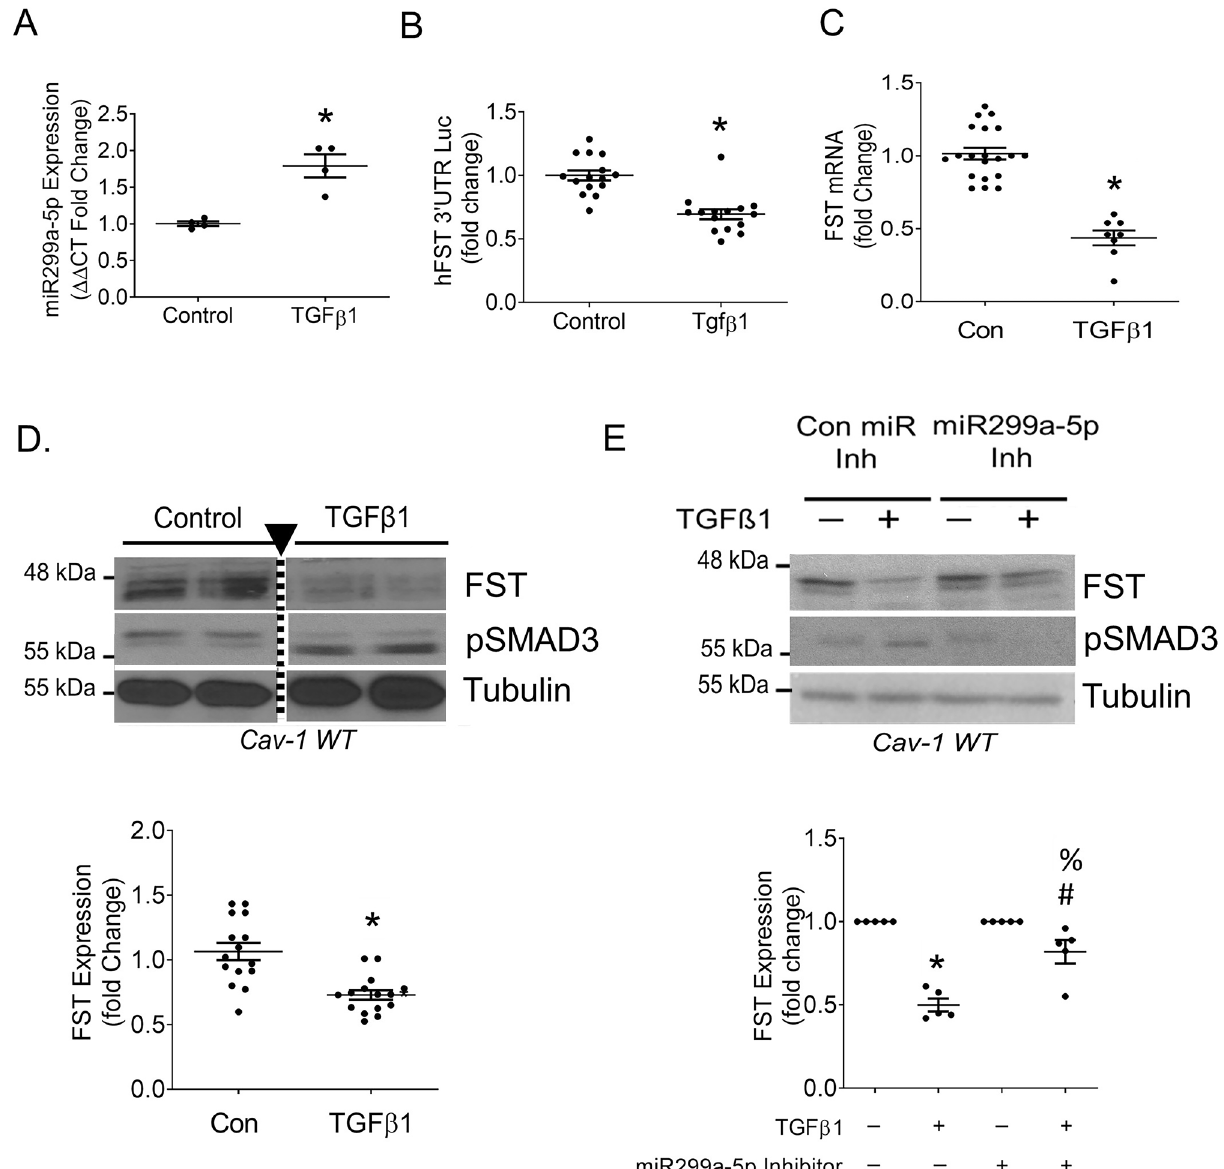
Figure 3. TFGβ1 represses FST through miR299a-5p upregulation in cav-1 WT MC. ( A ) TGFβ1 (5 ng, 24 h) increased the expression of miR299a-5p (n = 4, *p < 0.05) and ( B ) decreased stability of the FST 3 ′ UTR (n = 15, *p < 0.05). ( C ) TGFβ1 (5 ng, 24 h) reduced FST mRNA transcript (n = 8, *p < 0.05) ( D ) TGFβ1 (5 ng, 24 h) reduced FST protein expression (n = 4, *p < 0.05), while inducing phosphorylation of Smad3, triangle pointing to the dotted line indicates an edit made on the immunoblot image, where additional lanes not relevant to the experiment were cropped out, full gel provided in Sup Fig. S8). ( E ) Inhibition of miR299a-5p blunted the ability of TGFβ1 (5 ng, 24 h) to reduce FST protein expression, while reducing the phosphorylation of Smad3 (n = 5, *vs con inh-con, #vs miR inh-con, %vs con inh-TGFβ1, p < sion in cav-1 WT MC, and observed that this significantly blunted the ability of TGFβ1 to induce extracellular matrix (ECM) proteins and the profibrotic cytokine connective tissue growth factor (CTGF) (Fig. 4A). To deter- mine whether this protective effect was due to increased FST expression, we inhibited both miR299a-5p and FST, the latter using siRNA. As expected, the downregulation of FST using FST-targeting siRNA (Sup Fig. S1A), in the presence of miR299a-5p inhibition, enabled TGFβ1 induction of ECM protein and CTGF production (Fig. 4C). miR299a-5p inhibition also blunted TGFβ1-induced Smad3 activation, as seen through pSmad3 immunoblot- ting (Fig. 4A) and assessment of Smad3 transcriptional activity using the Smad3 reporter CAGA-12 luciferase (Fig. 4B). These results show that miR299a-5p mediates TGFβ1 profibrotic responses through repression of FST and consequent effects on Smad3 activation. We previously showed that cav-1 KO MC exhibit significantly decreased ECM protein expression in response to numerous profibrotic stimuli, including TGFβ1 10–13 . We recently showed that the elevated expression of FST by